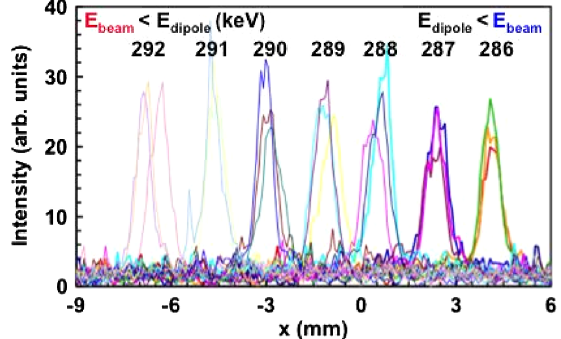
FIG. 5. Displacement of energy profiles transported through the spectrometer about the focal plane. All profiles are transverse slices of the beam integrated over a 500 ns gate in the middle of the 3 (cid:1) s pulse projected onto the x axis at the focal plane. The equivalent energy on the dipole in keV is labeled in